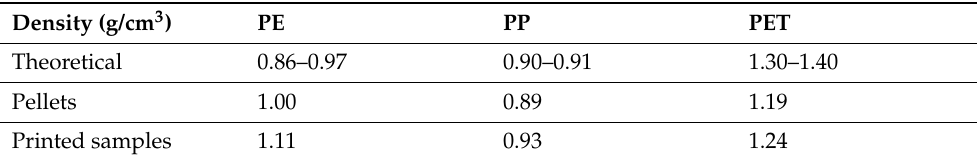
Table 2. Density of recycled polymeric